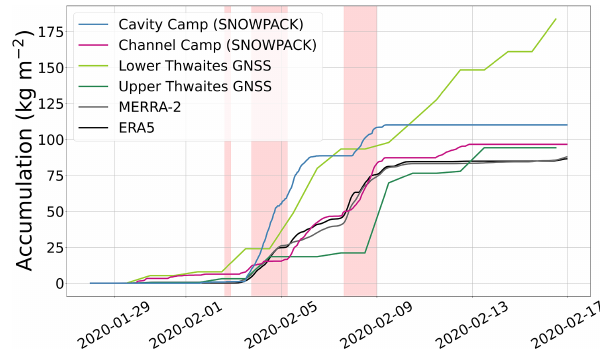
Figure 8. Reconstructed accumulation at Cavity Camp (blue) and Channel Camp (pink) sites on Thwaites Eastern Ice Shelf during the AR family event. AMIGOS observations of snow height and atmospheric conditions are used to force SNOWPACK with radi- ation provided by MERRA-2. Light purple and dark purple lines show GNSS–IR-derived accumulation at Lower Thwaites and Up- per Thwaites, respectively. We also show accumulation only from MERRA-2 (gray) and ERA5 (black). Pink shading indicates the timing of the AR